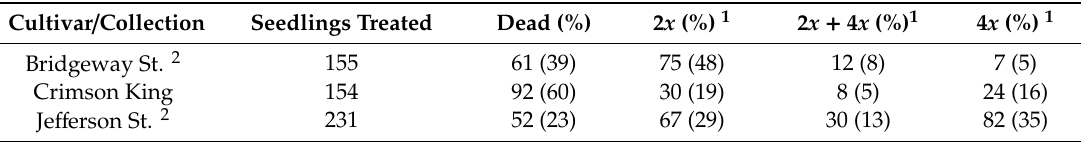
Table 3. Seedlings of Acer platanoides (Norway maple) collected and treated during 2010, for 5 d with 25 µ L of 150 µ M oryzalin supplied as Surflan + 0.55% agar for 5 d. Ploidy analysis conducted during